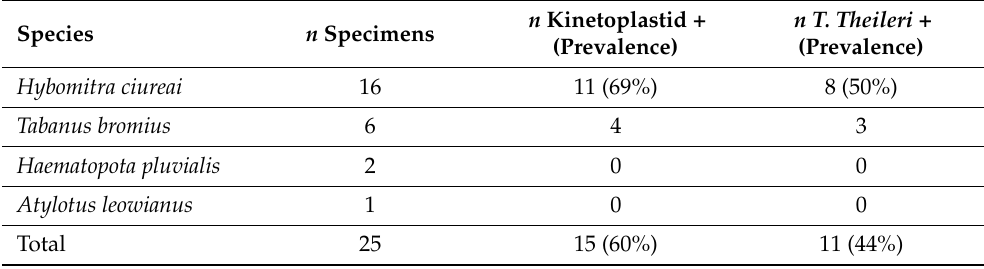
Table 2. T. theileri detection in tabanids. n specimens: number of tested samples, n Kinetoplastid+: number of kinetoplastid-positive specimens, n T. theileri +: number of T. theileri positive samples confirmed by sequencing.